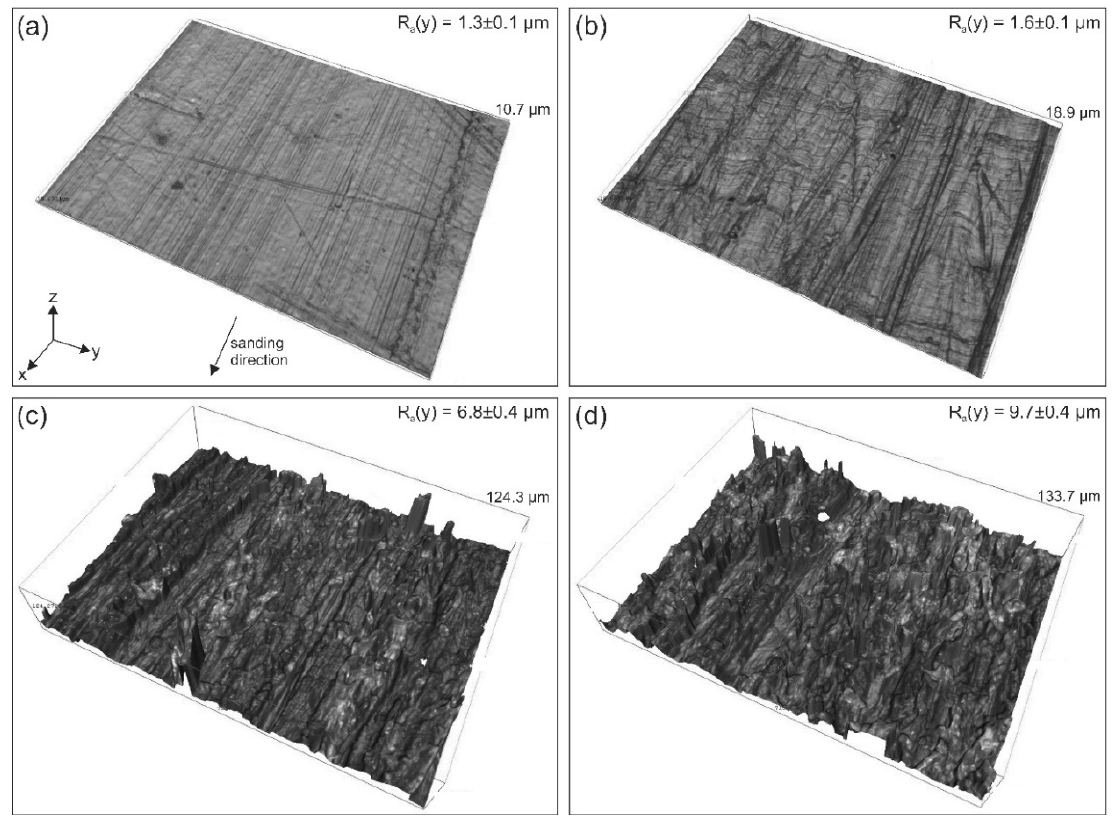
Figure 6. Topography images of the UHMW-PE building platform: Unmodified ( a ); sanded by a scrub sponge ( b ); by sandpaper with an average particle diameter of 82 µm ( c ); and by sandpaper with an average particle diameter of 190 µm ( d ). All images show an area of 710 × 538 µm 2 . The coordinate system in ( a ) represents the specimen orientation for all scanned samples. The sanding orientation is in the x-direction, as highlighted in ( a ). In the top right corners, the corresponding mean and standard deviation of the surface roughness (R a (y)), measured in the y-direction, are shown. The maximum height of the measured profile is presented next to each topography image.